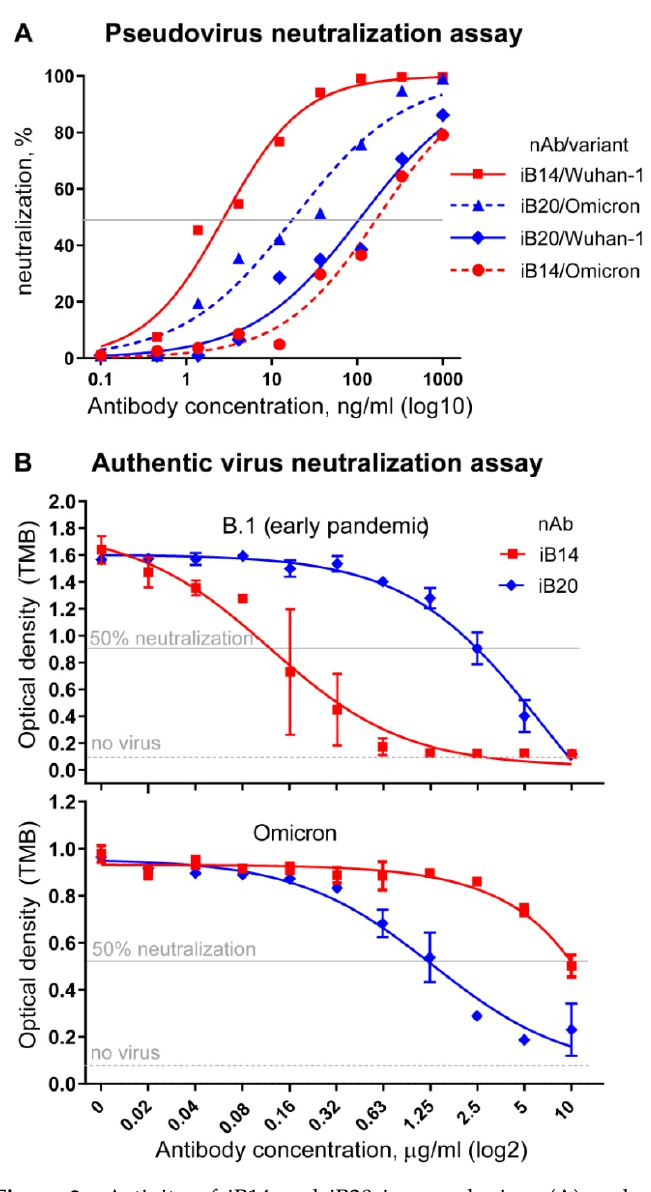
Figure 2. Activity of iB14 and iB20 in pseudovirus ( А ) and authentic SARS ‐ CoV ‐ 2 ( B ) virus ‐ neutralization assays. Early pandemic (Wuhan ‐ 1 or B.1) and Omicron variants were used.